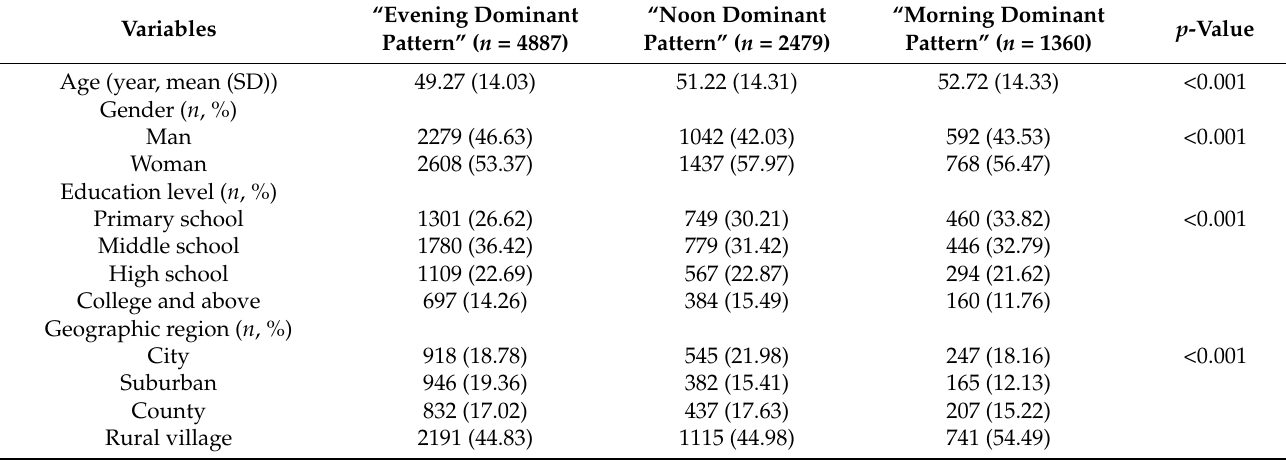
Table 2. Sociodemographic characteristics, lifestyles, and cardiometabolic risk factors by latent classes. Variables